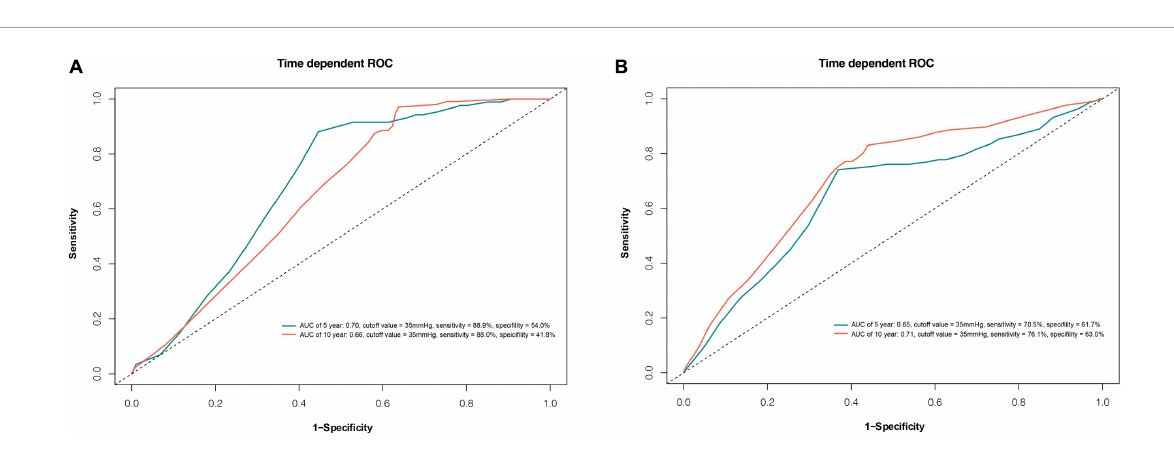
FIGURE5 Time-dependent receiver operating characteristic (ROC) curve for pulmonary artery systolic pressure (PASP) at follow-up with optimal cut-off point best predicting death (A) and AF recurrence (B) . AUC, area under